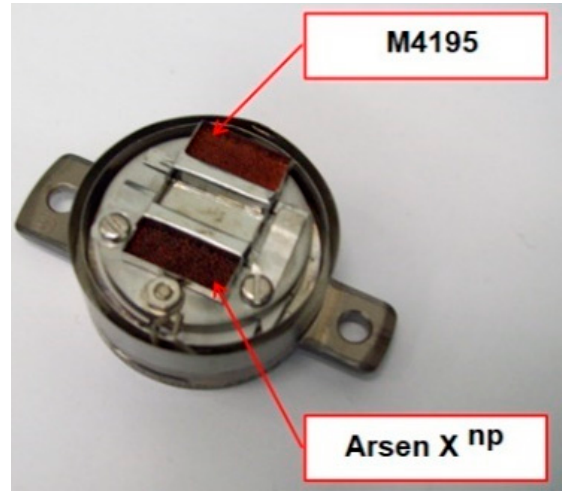
Figure 6. Samples mounted on a